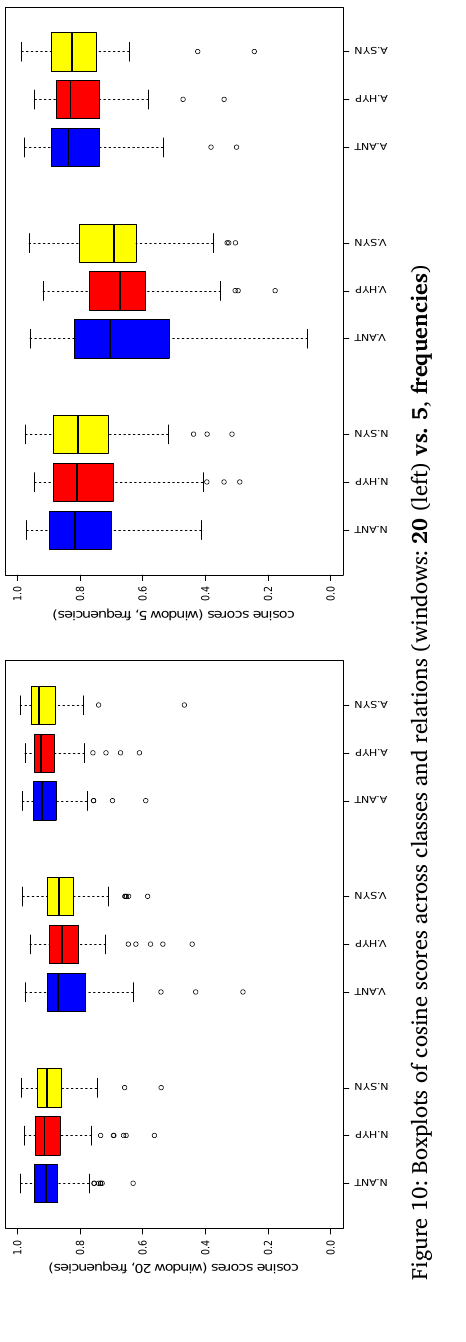
cosine scores (window 20, frequencies)